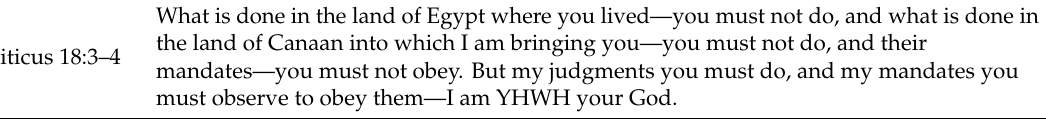
Table 1. Rhetoric of Separation in